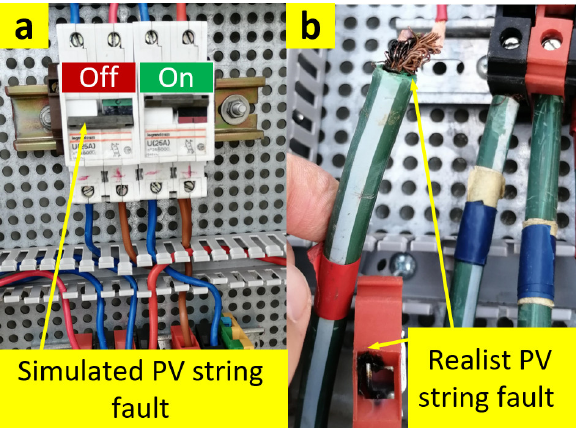
Figure 24. Photos of the ( a ) simulated and ( b ) realist PV string fault.